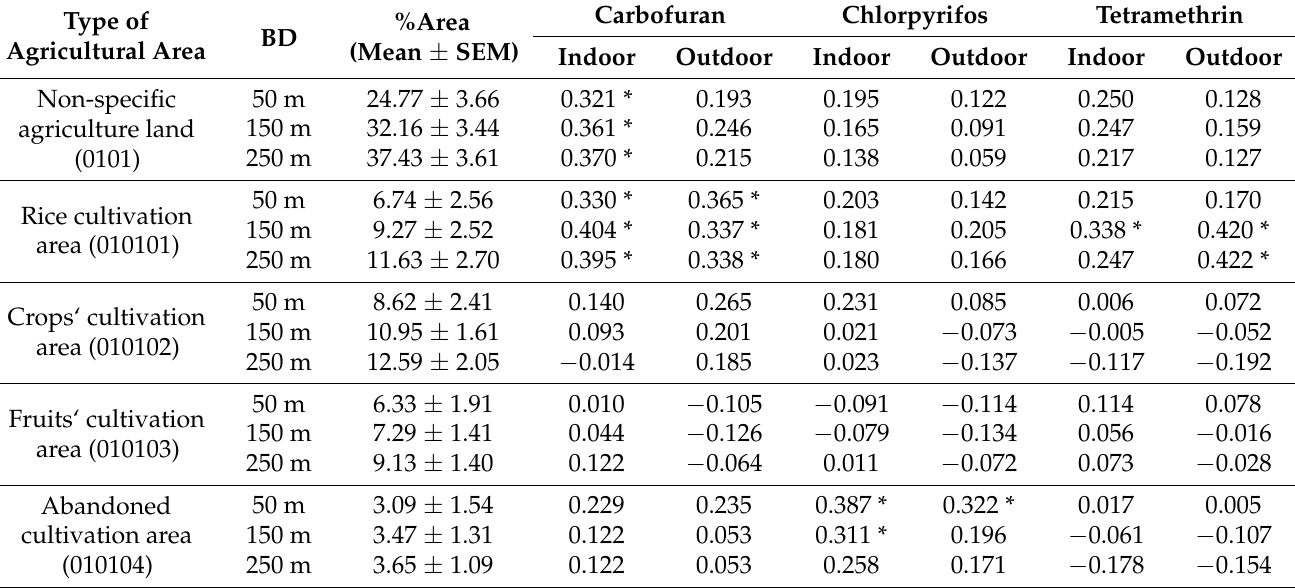
Table 5 indicated the Spearman correlations between pesticide concentrations in house dust and percentages of agricultural land use within three buffer distances (50 m, 150 m, and 250 m). It appeared that the percentage of agricultural land use increased with the buffer distance, indicating the characteristics of countryside for the sampling houses. None of fipronil, prallethrin and cypermethrin in house dust was significantly correlated with agricultural land use within any buffer zone; thus, those data were excluded from Table 5. Carbofuran in indoor dust was correlated significantly with the non-specific agriculture land and rice cultivation area within all buffer zones ( ρ = 0.321~0.404, p < 0.05), but that in outdoor dust was limited to correlate with rice cultivation area ( ρ = 0.337~0.365, p < 0.05). Chlorpyrifos was significantly associated with abandoned cultivation area within certain buffer zones ( ρ = 0.311~0.387, p < 0.05), whereas tetramethrin in indoor and outdoor dust was found to relate to rice cultivation area at the buffer distance of 150 m ( ρ = 0.338, 0.420, p < 0.05). None of the pesticides was associated with crops’ cultivation area or fruits’ cultivation area. Table 5. Spearman correlation between pesticides concentration in house dust and agriculture percent acreage within 50 m, 150 m, and 250 m buffer